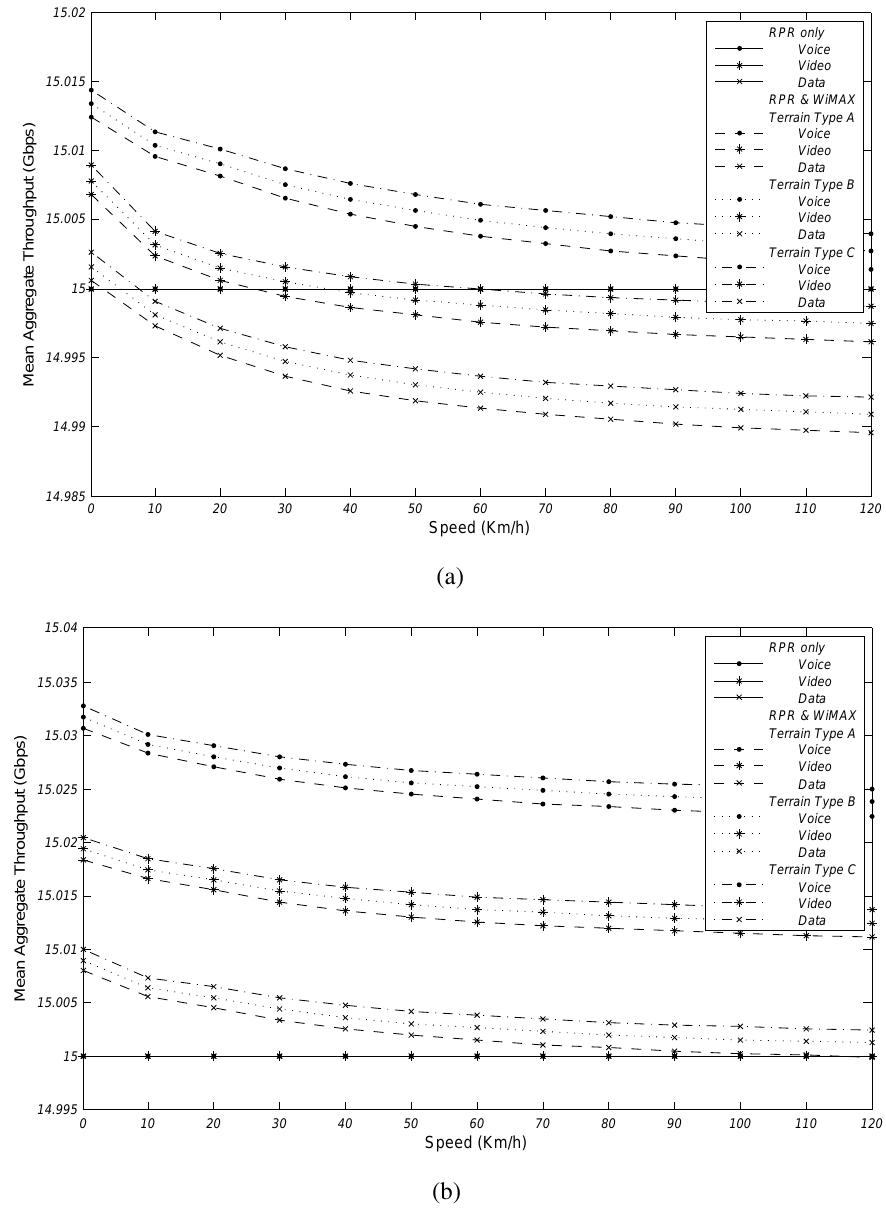
Figure 10. Mean aggregate throughput versus mobile SS speed with 25 attached mobile WiMAX SSs and 15 Gbps RPR background traffic for different terrain types using: (a) WFQ scheduler and (b) hierarchical WiMAX